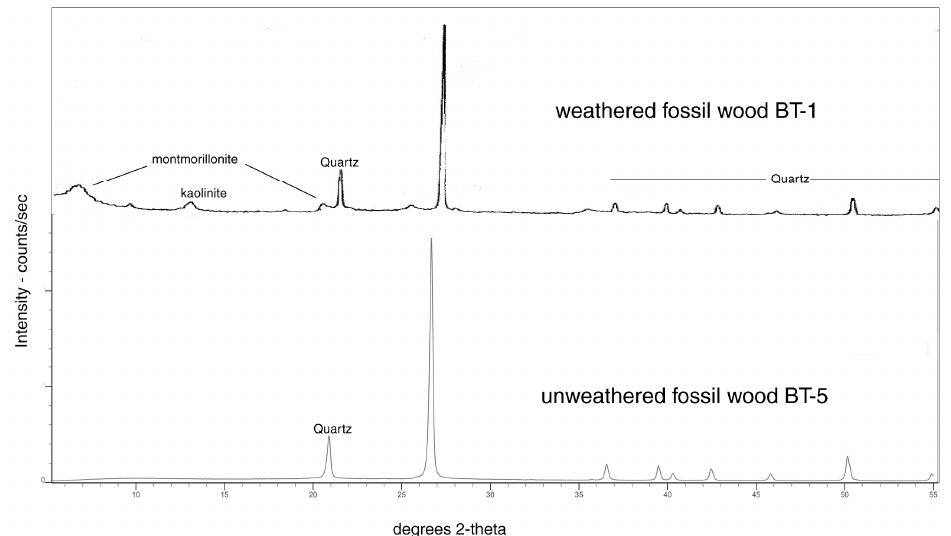
Figure 4. XRD pattern, specimen BT-5c, showing quartz as the only detectable constituent compared to weathered outer zone of BT-1, which shows presence of montmorillonite, illite, and quartz. This weathered zone also contains amorphous iron oxide, not detectable by XRD.